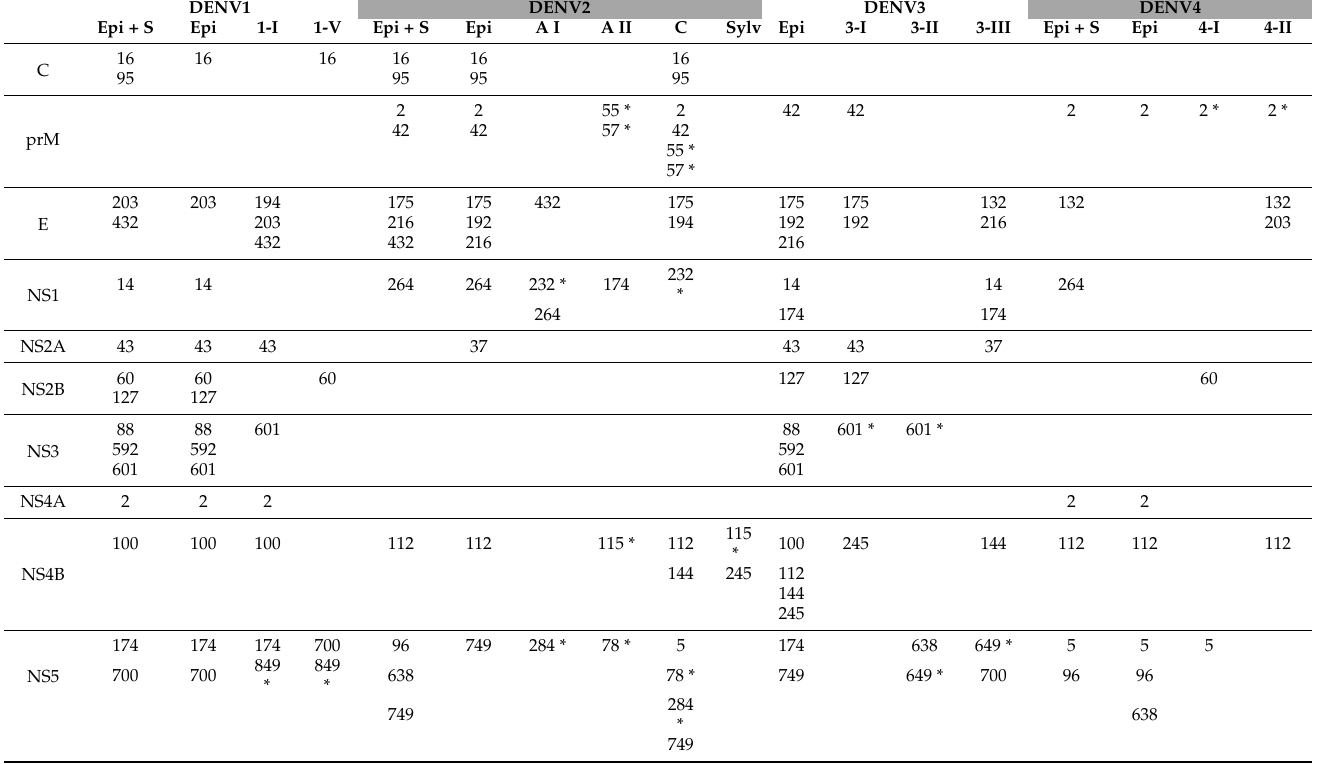
Table 3. Shared amino acid sites identified to be undergoing episodic positive selection for DENV1, DENV2, DENV3, and DENV4 whole genome coding sequences: (1) epidemic isolates [Epi], (2) com- plete datasets (epidemic, sylvatic, and highly divergent) [Epi + S], (3) sylvatic isolates (DENV2) [Sylv], and (4) individual genotypes. AI = Asian I, AII = Asian II, and C = Cosmopolitan. Number corresponds to site on the specified protein. Sites shared across genotypes within each serotype are identified with *. Unlisted genotypes did not share any positively selected sites. Grey is used to more clearly demarcate where the set of columns begin and end for each